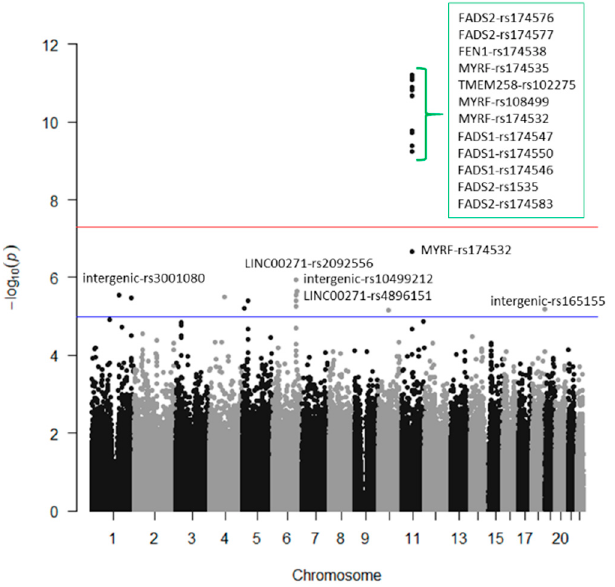
Figure 7. GWAS for serum docosahexaenoic fatty acid (%) in the whole population .